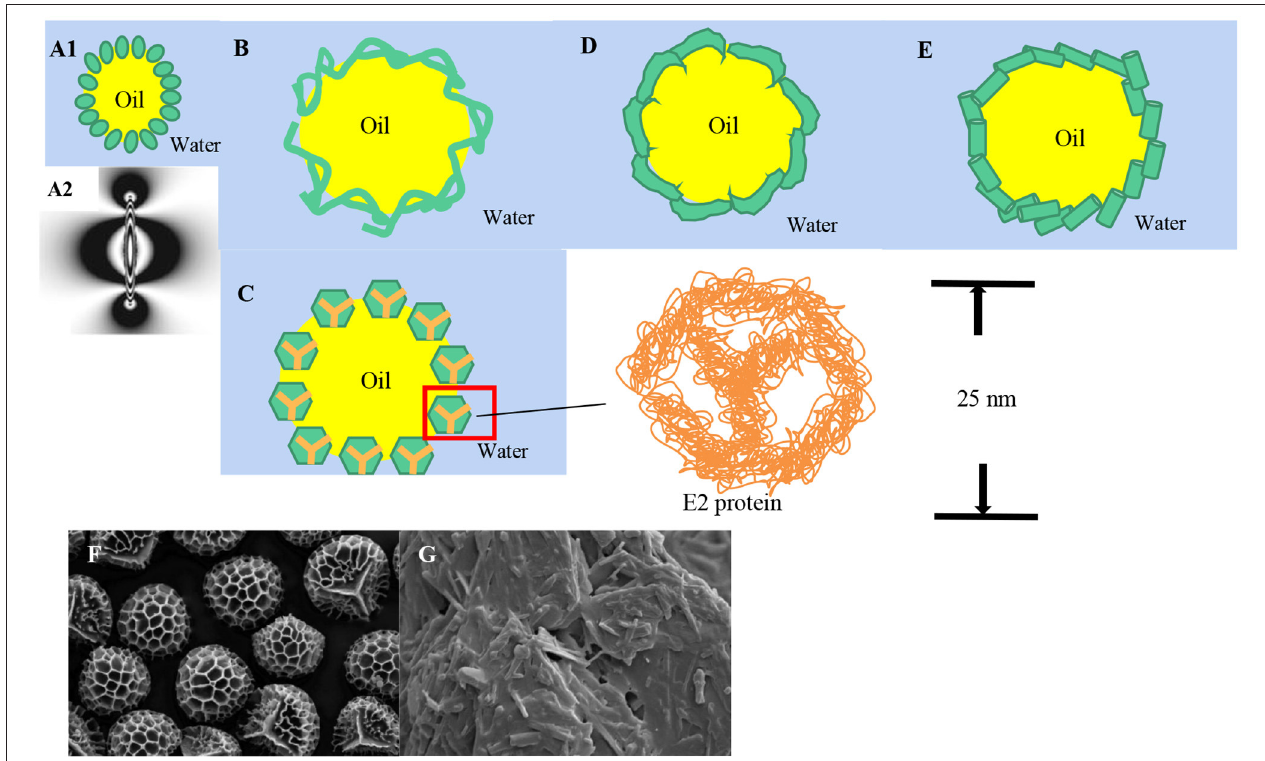
FIGURE 3 | Food-grade particles are of different shapes. (A) Interface deformation of ellipsoidal particles; (B) Nanofibrils particles; (C) E2 protein nanocages; (D) Disk solid particles; (E) Nanotubes; (F) SEM image of dry Lycopodium clavatum spore; (G) SEM micrographs of original phytosterol. (Reused from Liu et al. [(50, 59, 60) with